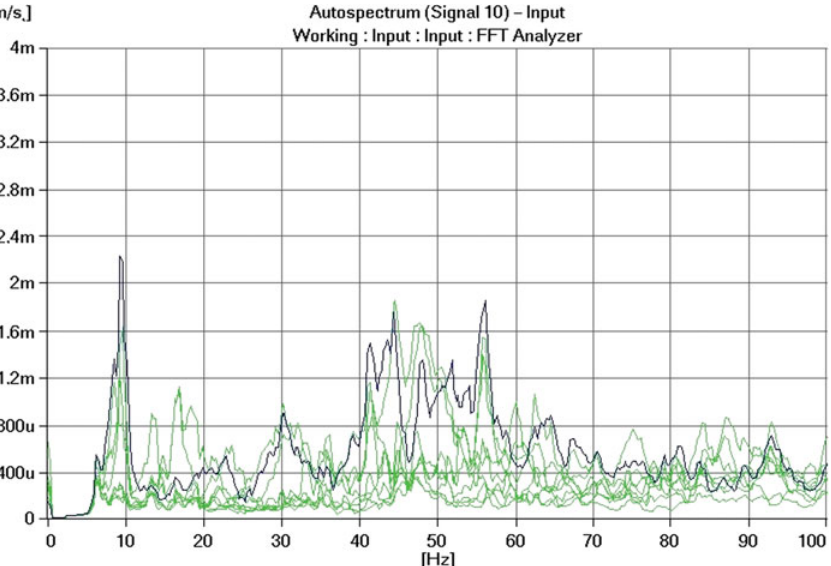
Fig. 16. Autospectrum of acceleration measured on the concrete floor slab, bandwidth 0 (cid:2) 100 Hz (Signal 10 (cid:2) blue line, the other signals (cid:2) green lines)